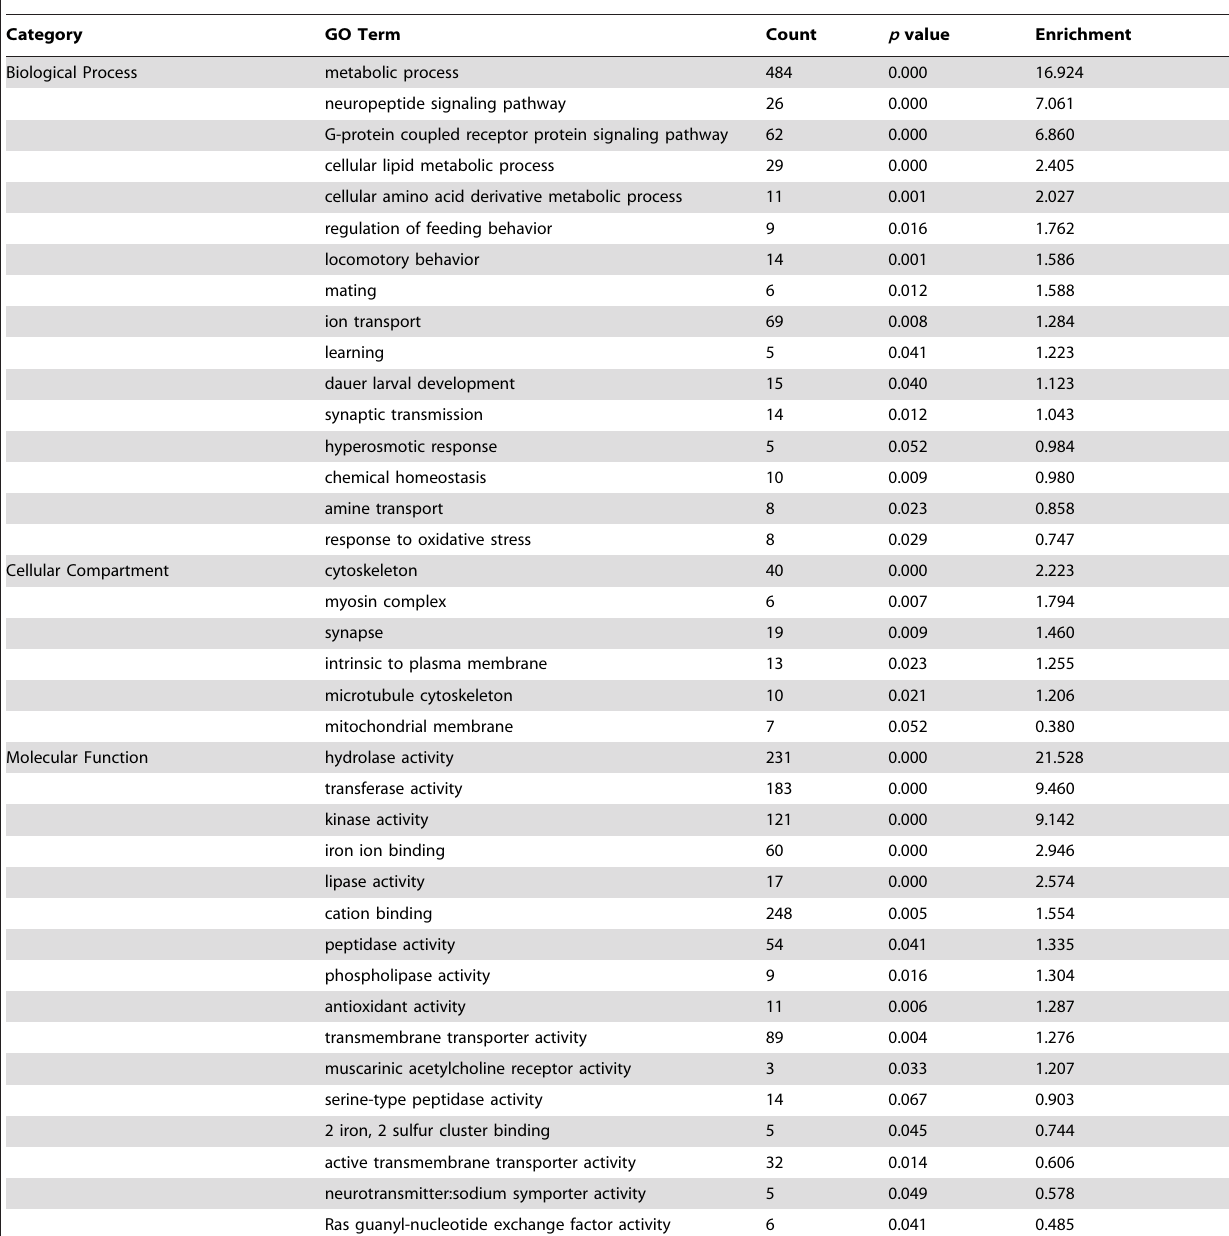
Table 1. Functional classification of genes up-regulated in wdr-23 mutants.